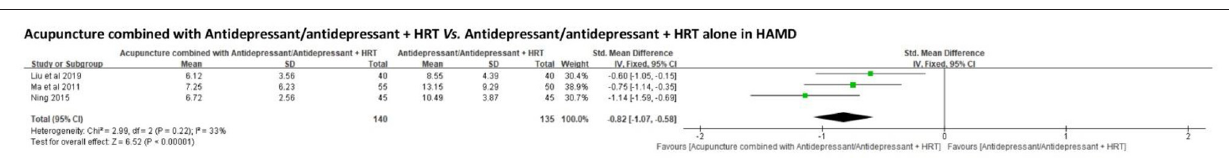
FIGURE 5 | Sensitivity analysis based on HAMD. HAMD, Hamilton Depression Scale.